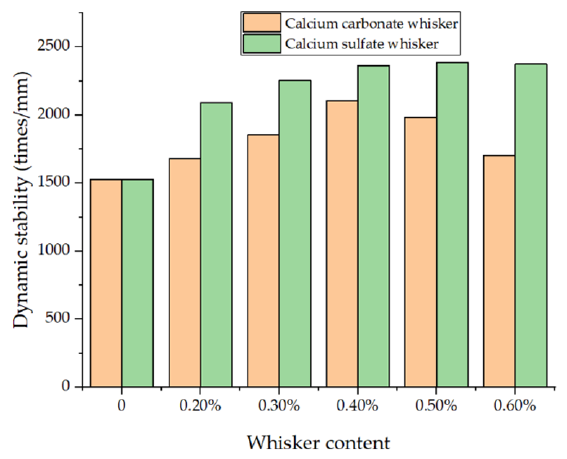
Figure 3. Rutting test results.